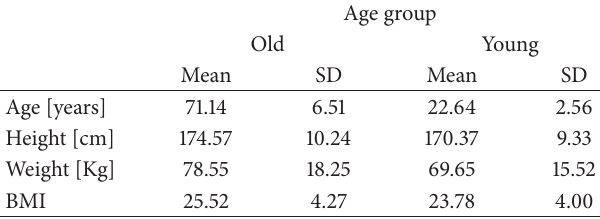
Table 1: Background characteristics of study participants.